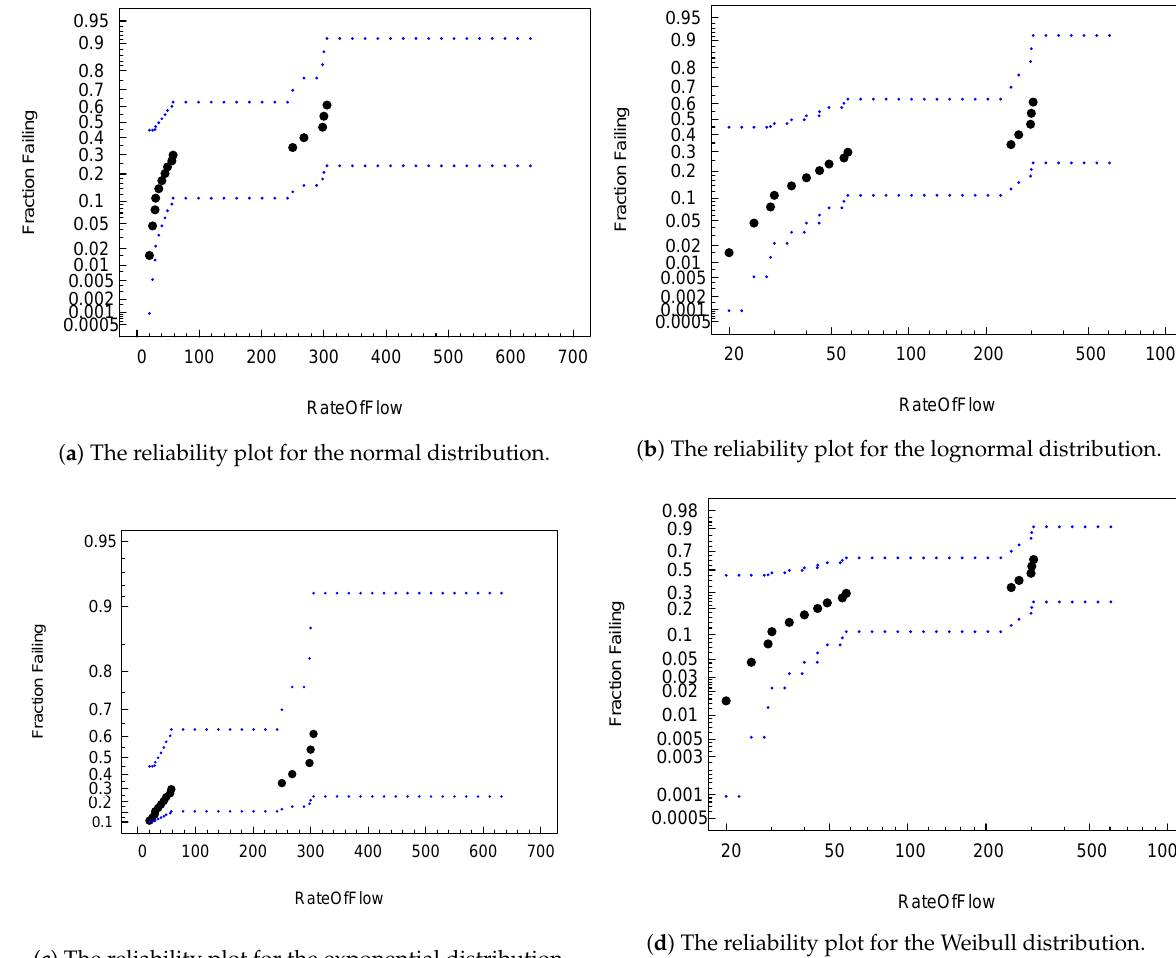
( d ) The reliability plot for the Weibull distribution. Figure 6. A plot to visualize the different distribution fits with failure